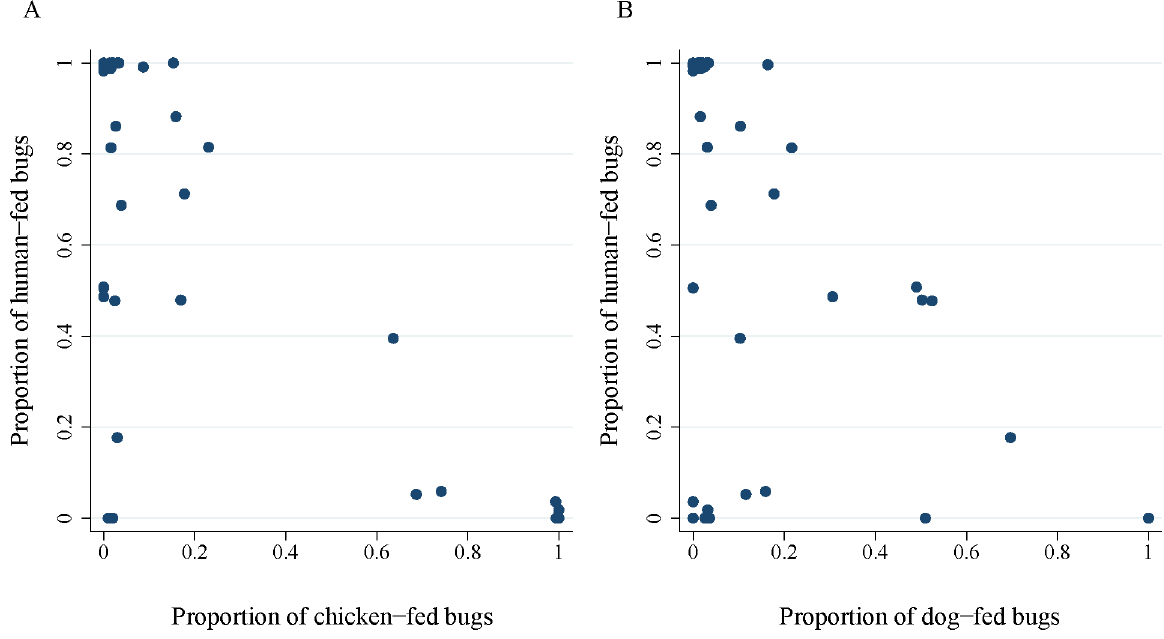
Figure 3. Proportion of late-stage domestic T.infestans that fed on humans (the human blood index) according to the proportion of bugs that fed on chickens (A) and dogs (B). Each data point corresponds to a different house. The human and chicken blood indices include bugs that fed on humans or chickens, respectively, regardless of feeding on other species. Figueroa, October 2003 (spring).